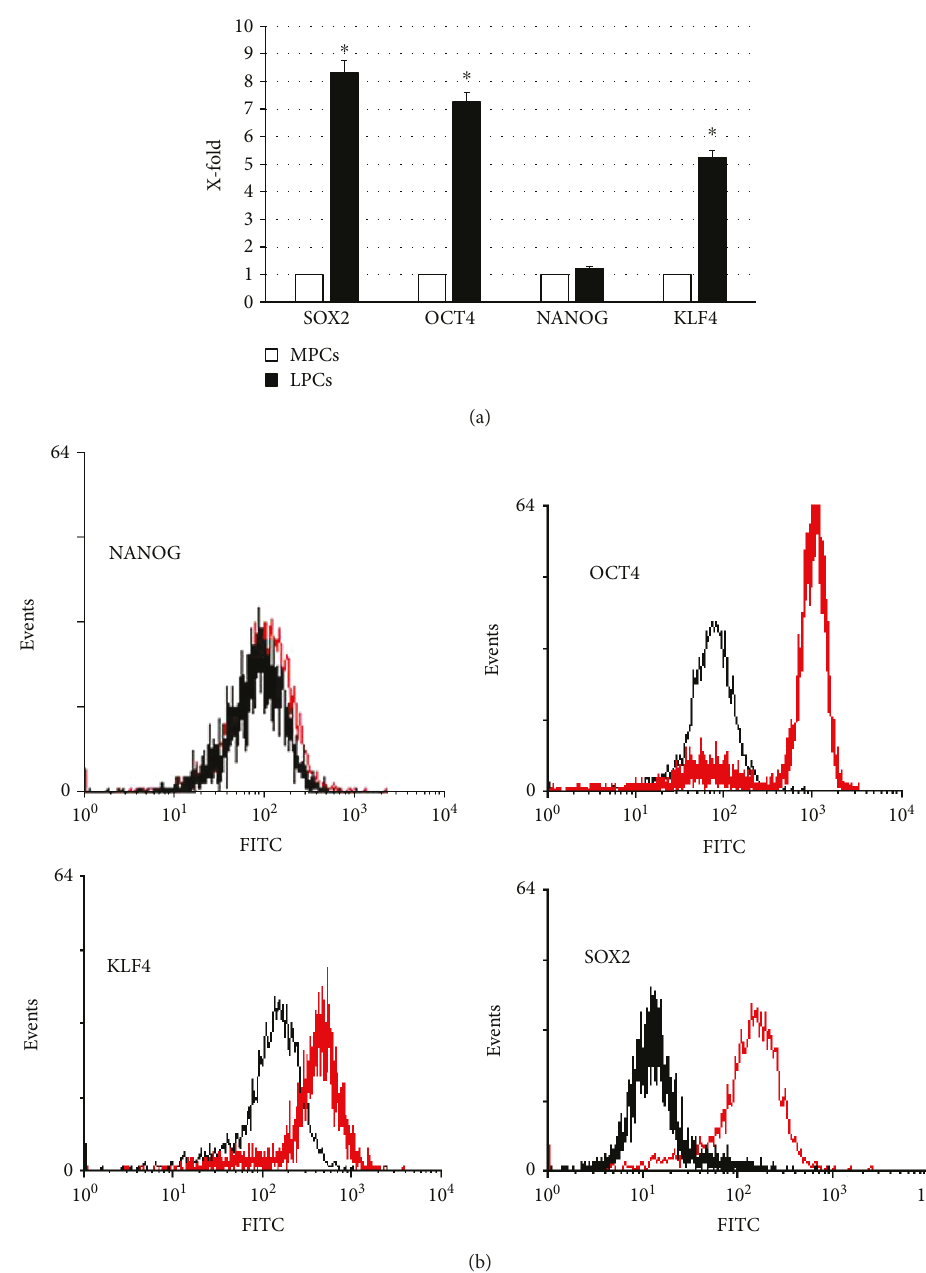
Figure 3: OCT4, SOX2, NANOG, and KLF4 expression. Selected markers of self-renewal and di ff erentiation potential (OCT4, SOX2, NANOG, and KLF4) were evaluated by RT-PCR (a) and cyto fl uorometry (b). For PCR analysis, the expression levels measured in LPCs are considered as X-fold with respect to MPCs (considered as 1). Data are mean ± SD of analyses performed in 12 di ff erent MPC and LPC cultures, upon three independent experiments in triplicates. ∗ p < 0 05 LPCs versus MPCs. For cyto fl uorometric analysis, representative FACScan analyses of cell-surface antigen expression, as indicated. Black histograms refer to the MPCs and red histograms refer to LPCs